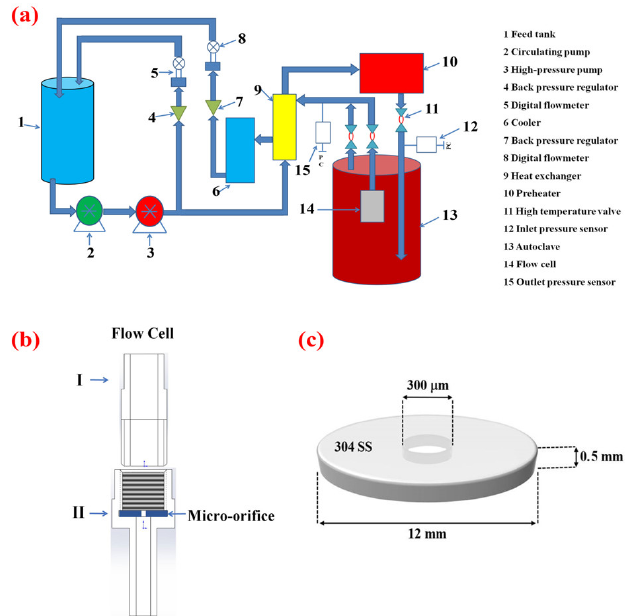
Figure 1. ( a ) Schematic diagram of the experimental system used in the present work. ( b ) Schematic diagram of the flow cell enclosing the micro-orifice test piece. ( c ) Schematic diagram of 304 SS disc with a micro-orifice of 300 μm in diameter in the center.